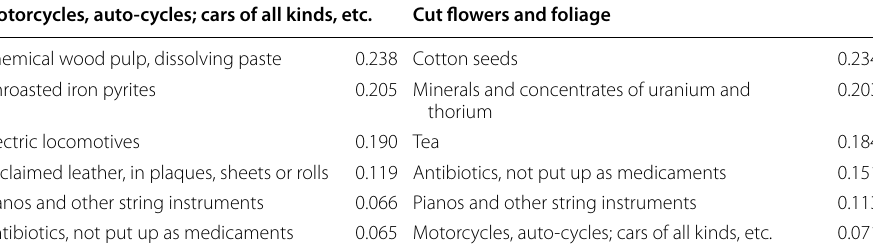
Table 6 Distance ( ϕ ik ) of some products with regard to flowers and vehicles. Source : Author’s